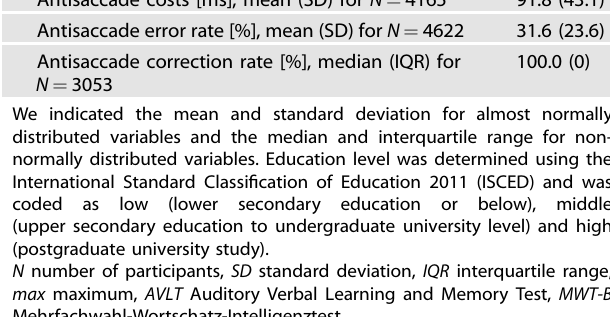
Exclusion of AD cases ( N = 5, Table 1) from the sample, or adding educational level as an additional covariate, did not materially change the results (data not shown). Interaction effects We found signi fi cant interactions between the three different PRS and age and age 2 for TMT-A performance that remained signi fi cant after correcting for multiple testing (Table 3). For AVLT (immediate and delayed recall), the interactions between PRS and age and age 2 were also signi fi cant for all three different PRS, but only the interactions between PRS Jansen and age and age 2 for AVLT immediate recall remained signi fi cant after correcting for multiple testing. In addition, we found signi fi cant interaction effects between PRS Wightman , and PRS Schwartzentruber and age and age 2 for saccade frequency during smooth pursuit, but they did not survive correction for multiple testing. Visualisation of the interaction effects showed that individuals with the highest genetic risk for AD showed the strongest age-related decline in AVLT (immediate and delayed recall) and TMT A performances (Fig. 1). For saccade frequency during smooth pursuit, the scatterplot did not reveal a clear pattern (Fig. 1). Post-hoc comparisons using the Tukey test revealed that delayed recall performance in individuals at highest genetic risk, based on PRS Wightman and PRS Schwartzentruber was worse compared to those in the medium (PRS Wightman model: p = 0.001, PRS Schwartzentruber model: p = 0.025) and low (PRS Wightman model: p = 0.017, PRS Schwartzentruber model: p = 0.031) genetic risk groups. Addition- ally, high genetic risk individuals performed worse than medium (PRS